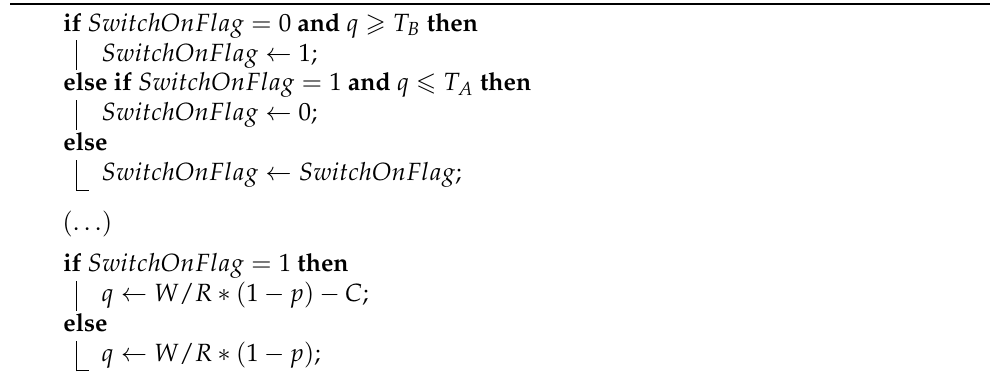
Algorithm 2: Energy-saving modification of fluid-flow